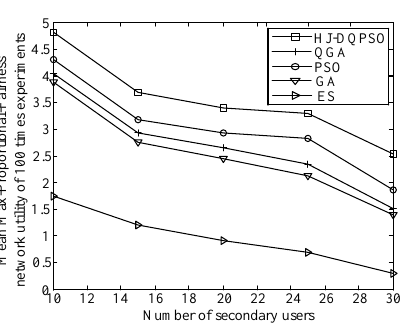
U with secondary users MPF